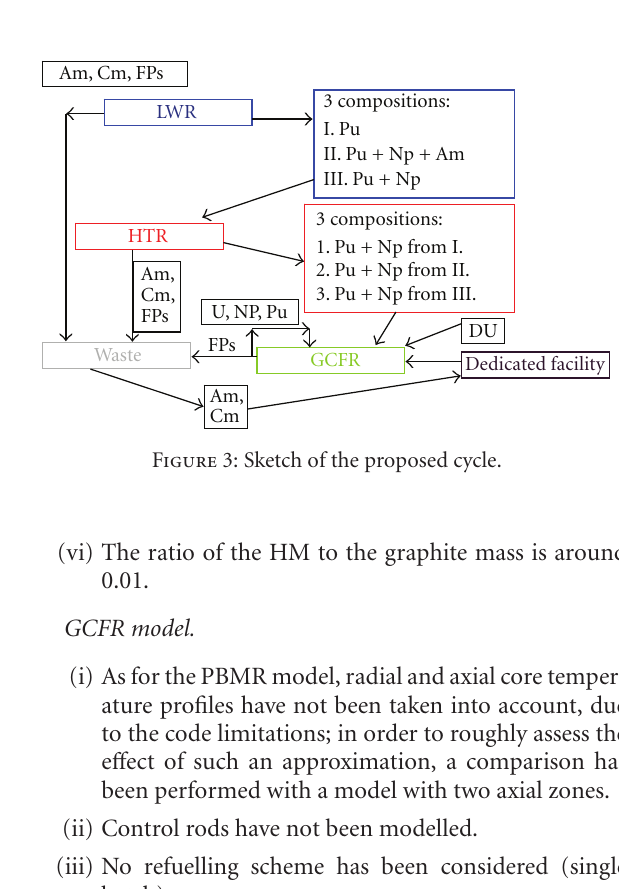
Figure 2: Monteburns workflow.